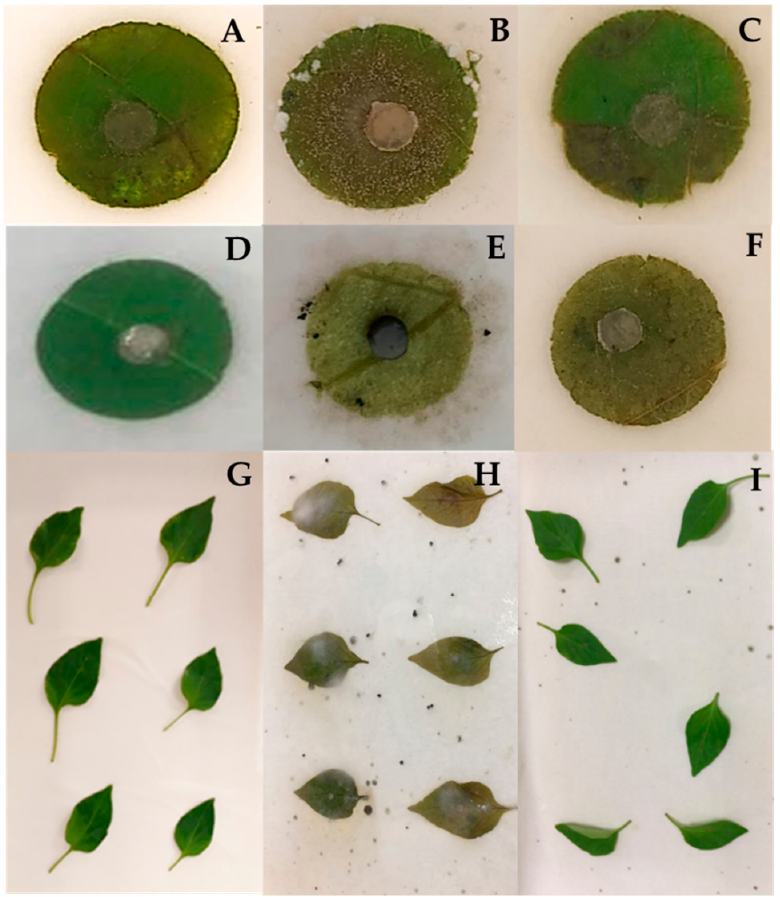
Figure 4. Symptoms of B. cinerea ( A – C ), M. melonis ( D – F ) and S. clerotiorum ( G – I ), infection on detached leaves treated with TAET1 ( A , D , G ), fungicide ( C , F , I ) or control ( B , E , H ).